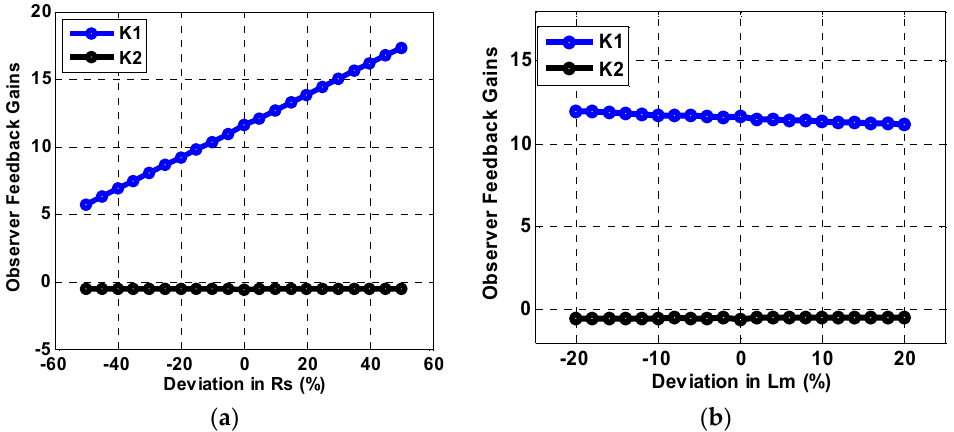
Figure 5. The optimal setting of observer feedback gains ( K 1 and K 2 ) at different deviations in R s and L m using PSO. ( a ) Under stator resistance deviation; ( b ) under magnetizing inductance deviation.